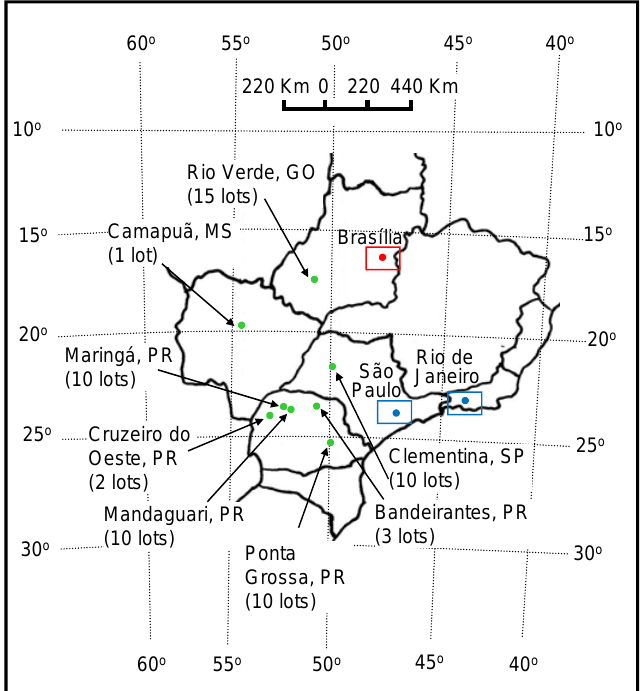
Figure 6. Map of Brazil indicating the cities and states where the maize seeds were obtained. The collected and analyzed number lots in each city are indicated. The largest cities in Brazil, São Paulo and Rio de Janeiro, and the capital, Brasília, are